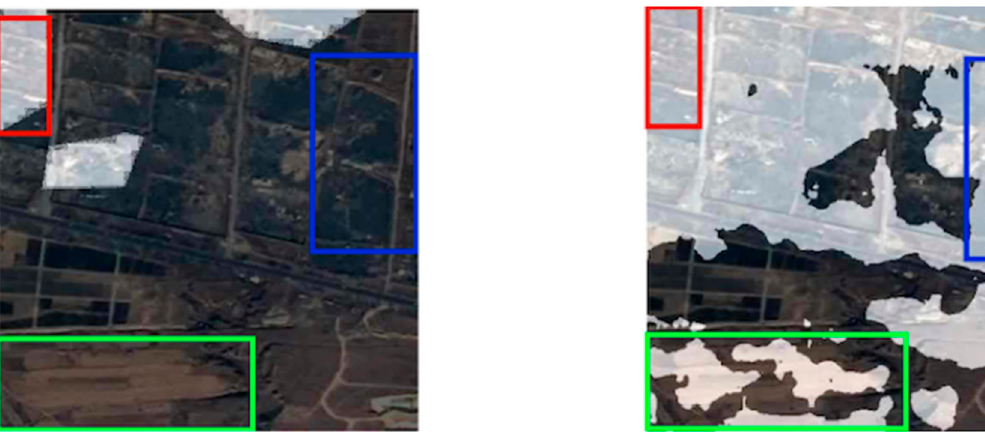
Figure 10. Cases of failure detection results. Red boxes, blue boxes, and green boxes denote accurately detected areas, ignored labeled detected areas, and wrongly detected areas, respectively.